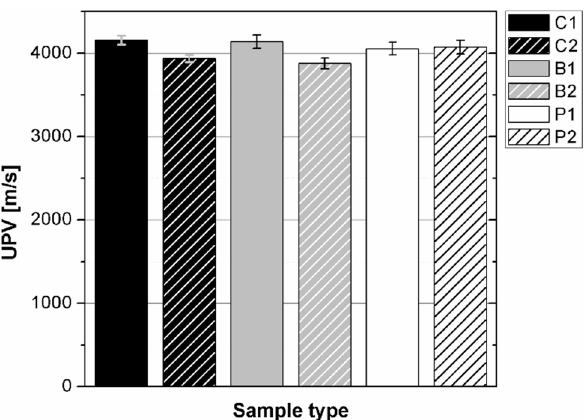
Figure 5. Pulse velocity in epoxy concrete samples of different types. Figure 6. Pulse velocity in epoxy concrete depending on the sample type and test plane.